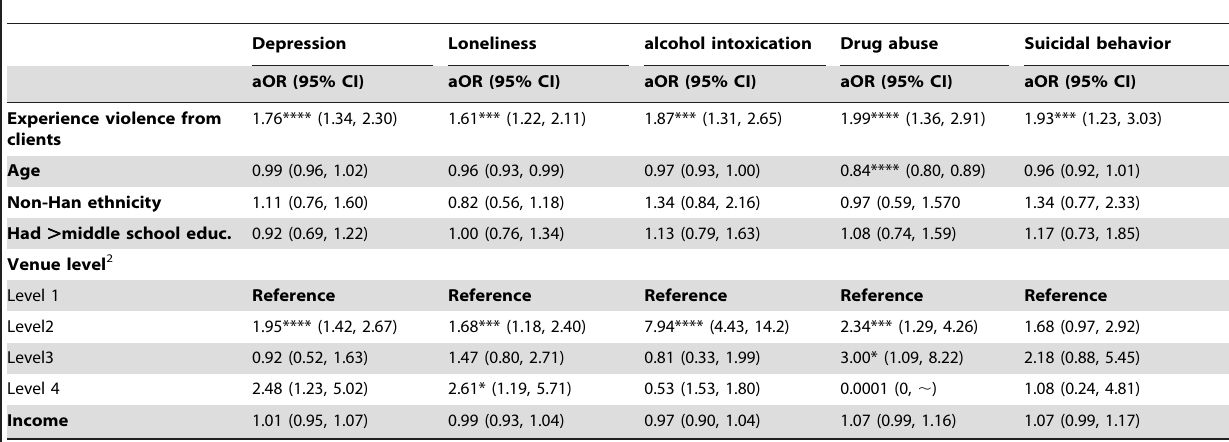
Table 5. Multivariate regression 1 of mental health indicators on partner violence from clients (N= 937) 1